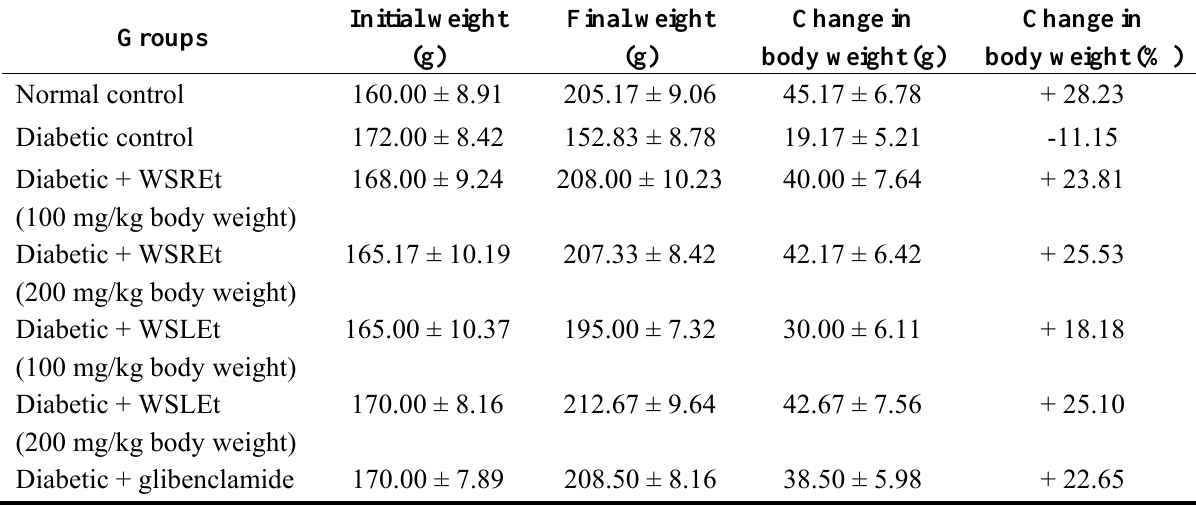
Table 2. Effects of W. somnifera (L.) extracts on body